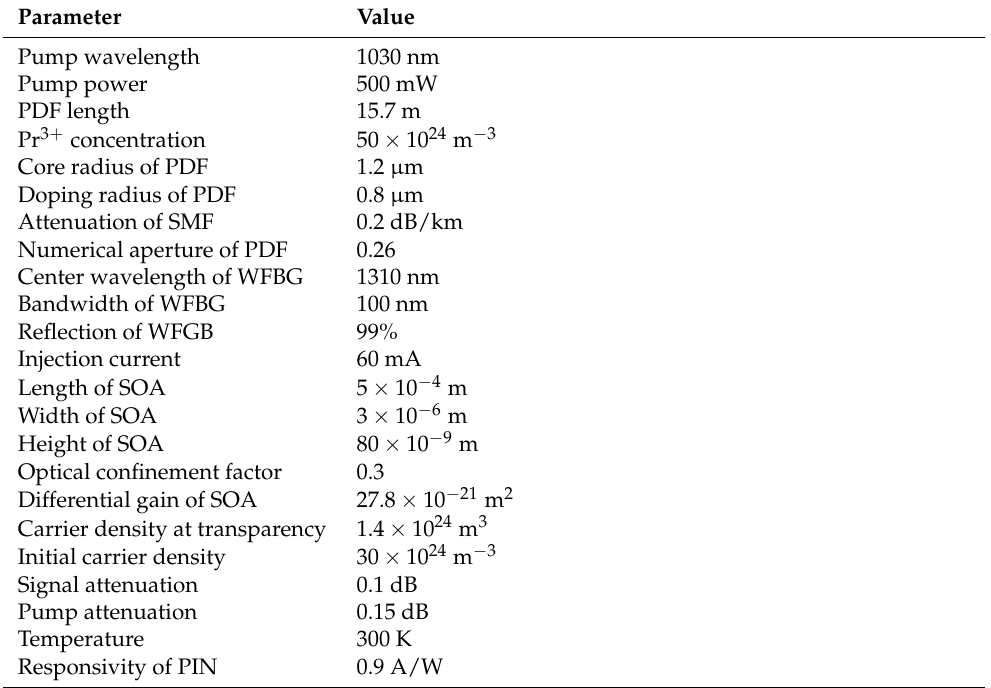
Figure 2. Schematic of ( a ) the proposed HOA and ( b ) the system-level integration of the HOA in an eight-channel CWDM transmission system. Table 3. Main simulation parameters and their